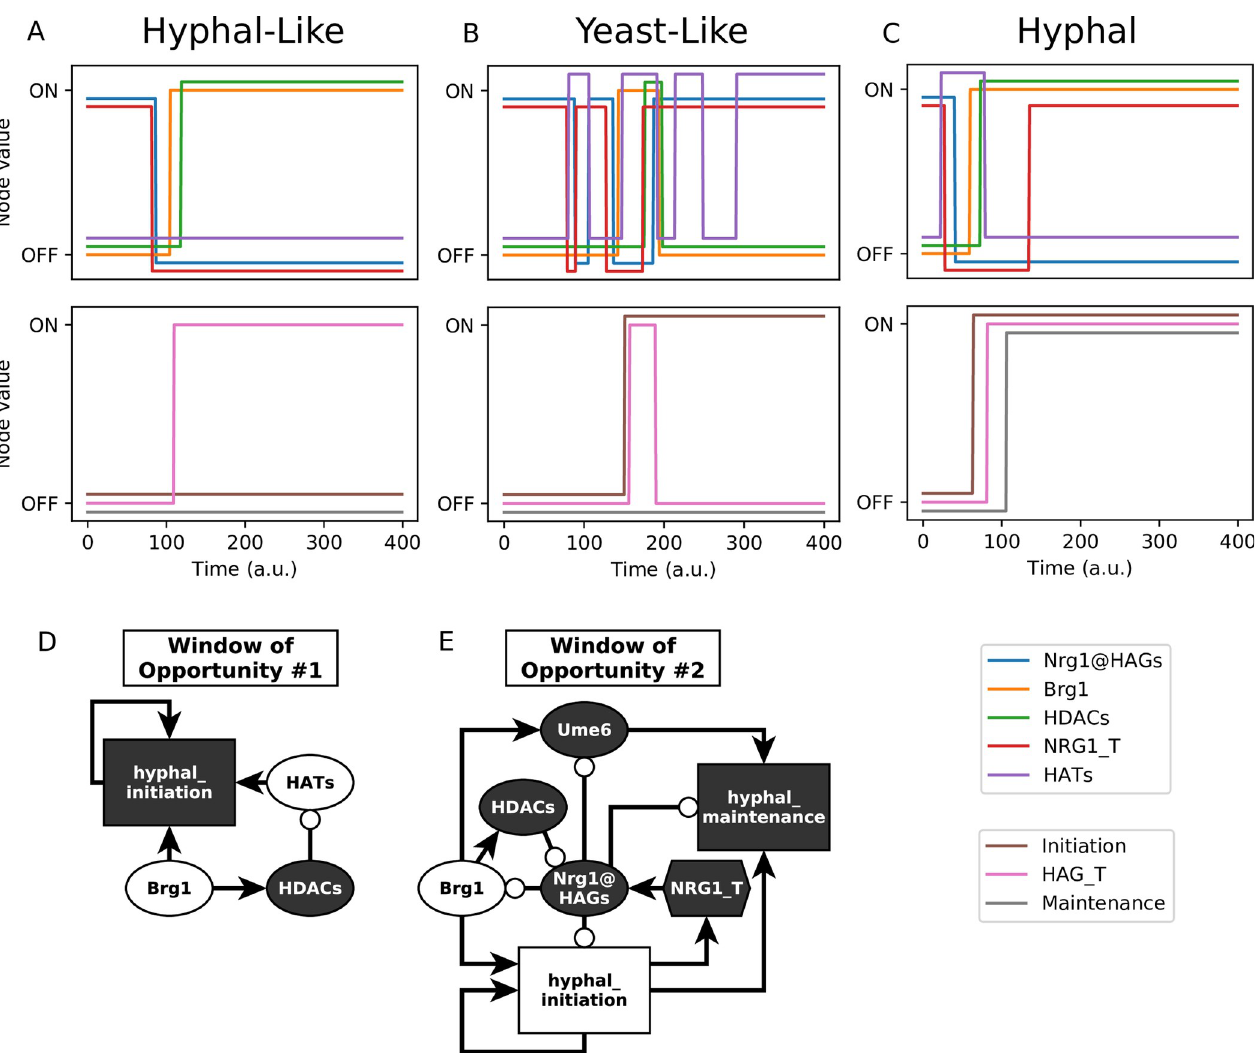
Fig 3. Trajectories to different attractors. (A-C) Illustrative trajectories of simulated yeast cells placed into an alkaline environment (pH = 1). Simulations use general asynchronous update. (A) A yeast cell fails hyphal initiation, yet hyphal-associated transcription factors (TFs) such as Brg1 are activated and HAGs are transcribed. This trajectory ends in the hyphal-like attractor. (B) A yeast cell achieves hyphal_initiation = 1, and transiently activates HAG_transcription; however, the cell fails to lock in hyphal_maintenance, and the yeast program is reestablished. This trajectory ends in the yeast-like attractor. (C) A yeast cell completes the YHT, and ends in the hyphal attractor. (D-E) Motifs from the network controlling these windows of opportunity. White nodes begin as ON at the start of the window of opportunity, while black nodes begin as OFF. (D) Once Brg1 is activated, hyphal_initiation must be activated before HATs are silenced to continue the YHT. If HDACs silence HATs first, the network cannot complete hyphal_initiation, and instead reaches a hyphal-like (pseudohyphal) phenotype. (E) NRG1_T must be silenced to begin hyphal_initiation, but can turn back ON once hyphal_initiation has started. If Nrg1@HAGs reactivates before Brg1 activates HDACs, the system reverts to a yeast-like phenotype. This window may be skipped entirely if HDACs have activated prior to hyphal initiation.